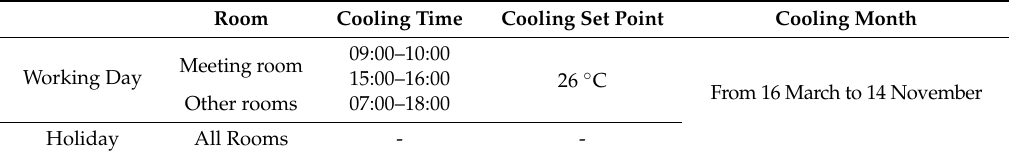
Table 10. Simulation parameters of space cooling conditions in Beijing.